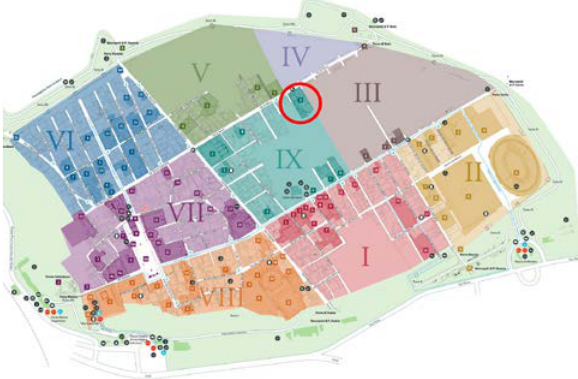
Figure 1. Pompeii city map: the red circle indicates the location of the Obellio Firmo domus (http://pompeiisites.org)